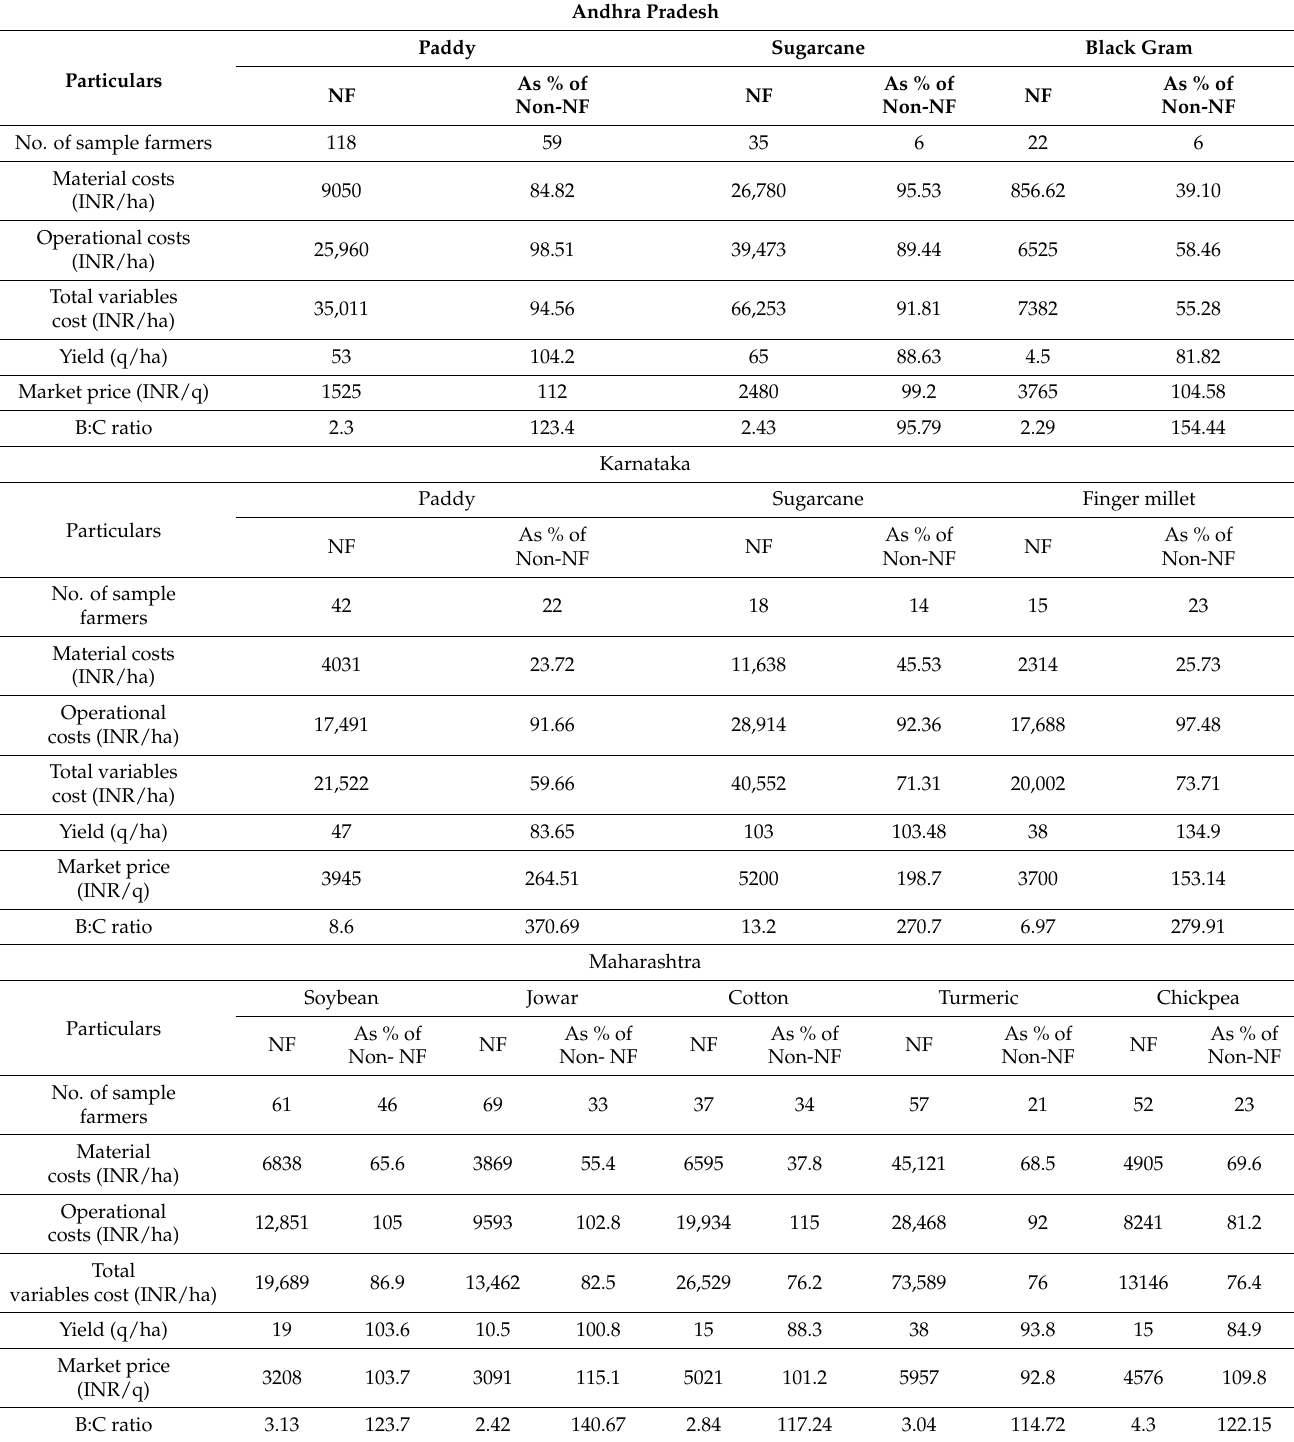
Table 3. Benefit–Cost comparison for major crops in selected states. Andhra